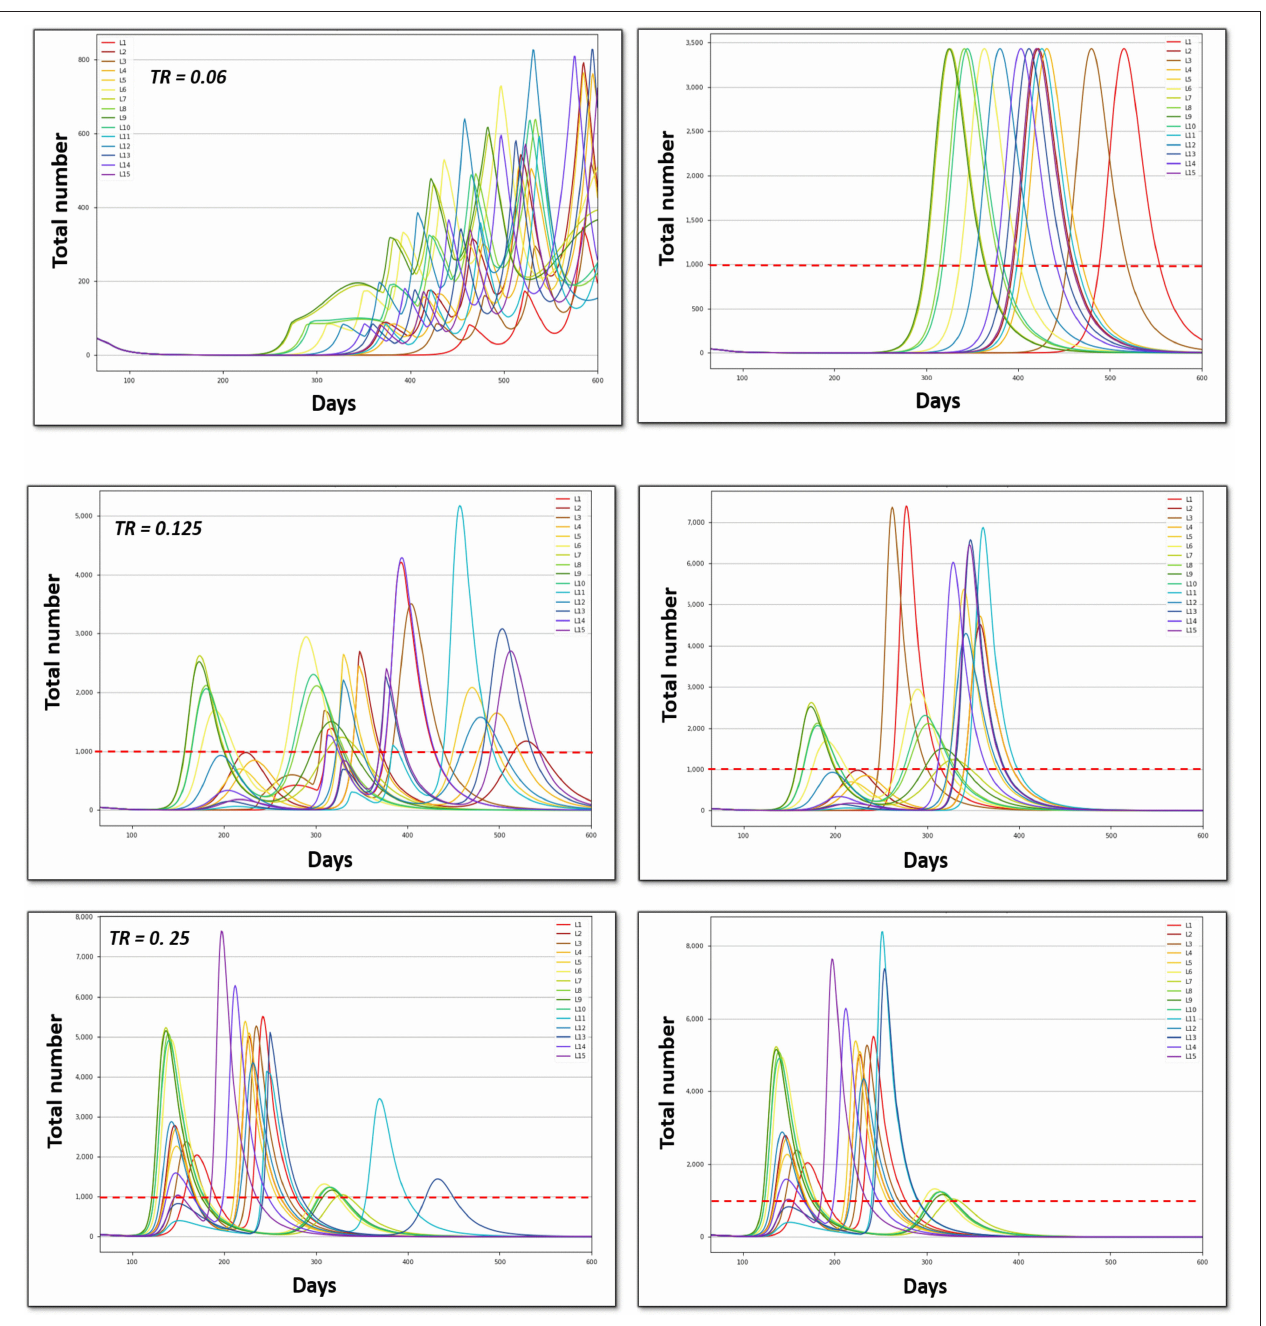
FIGURE 4 | Number of daily beds used in the hospital (ICU excluded) for the different scenarios (L1 to L15). Tr, transmission rate; the red dashed line represents the hospital capacity. Option O34 (left), progressive total lockdown lift (phase 3); Option O34 (right), abrupt total lockdown lift (phase 3).